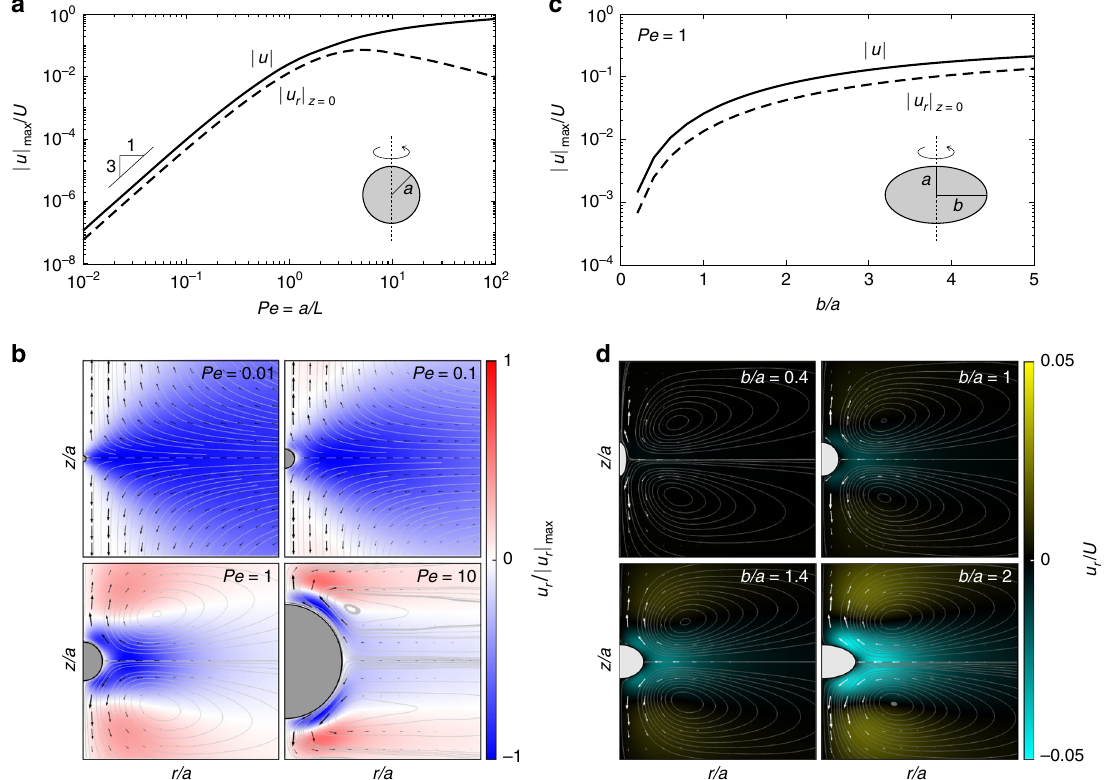
Fig. 3 Flow strengths and structures for spheres and spheroids. a Overall max velocity and equatorial maximum cylindrical radial speed, u r as a function of the Peclet number for spheres. b Flow structures induced by a sphere for four different Peclet numbers in a vertical plane slicing the sphere through north and south pole, color representing horizontal velocity scaled by its maximum value for each Peclet number. c Overall max velocity and equatorial maximum cylindrical radial speed as a function of the aspect ratio for spheroids. d Flow structures induced by four different spheroids, scaled by the Phillips velocity, U at Pe ¼